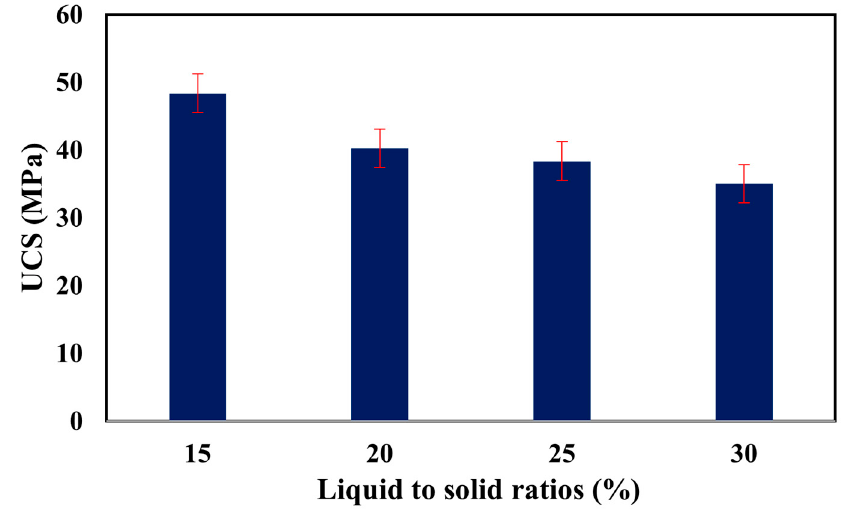
Figure 4. Effect of liquid-solid ratio on UCS.